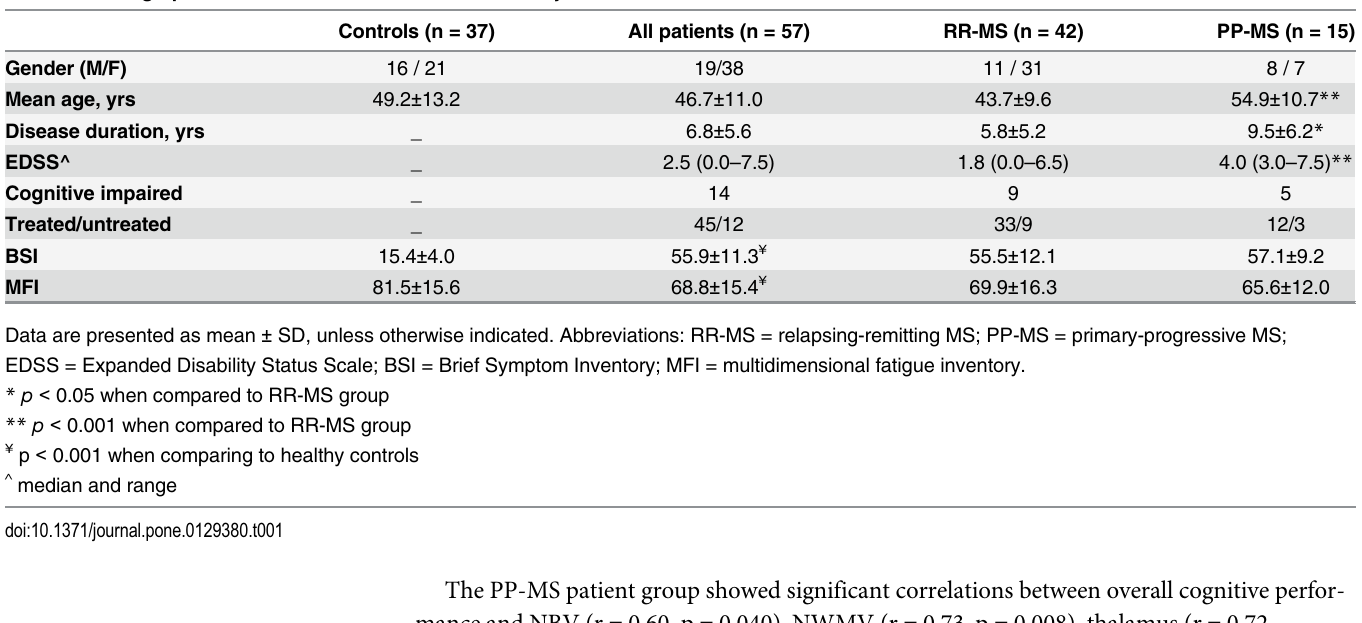
Table 1. Demographic and clinical characteristics of all subjects.